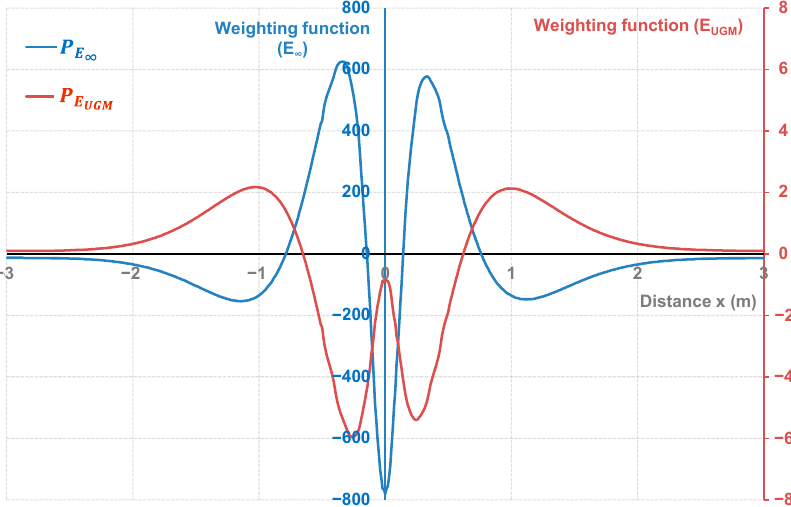
Figure 9. Weighting functions as a function of distance of E ∞ (blue axis in the center) and E UGM (red axis in the right) obtained from the reference signal.